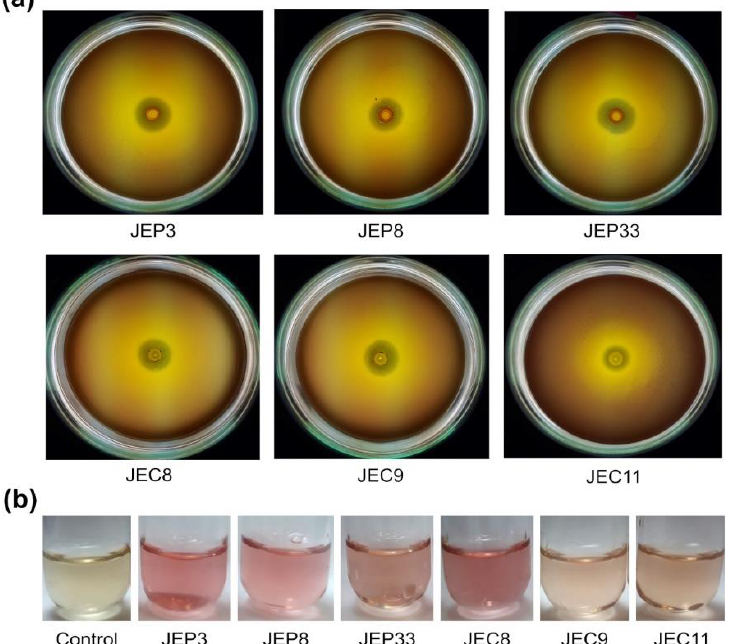
Figure 2. Plant-growth-promoting rhizobacteria (PGPR) traits of Pb- and Cd-tolerant bacterial isolates from Typha latifolia roots. ( a ) Phosphate solubilization activity of bacterial strains in NBRIP media after 15 days of incubation. A clear halo around the bacterial colony indicates phosphate solubilization. ( b ) Colorimetric determination of IAA and indole compounds in bacterial supernatants using Salkowski reaction. A pink color indicates positive reaction.